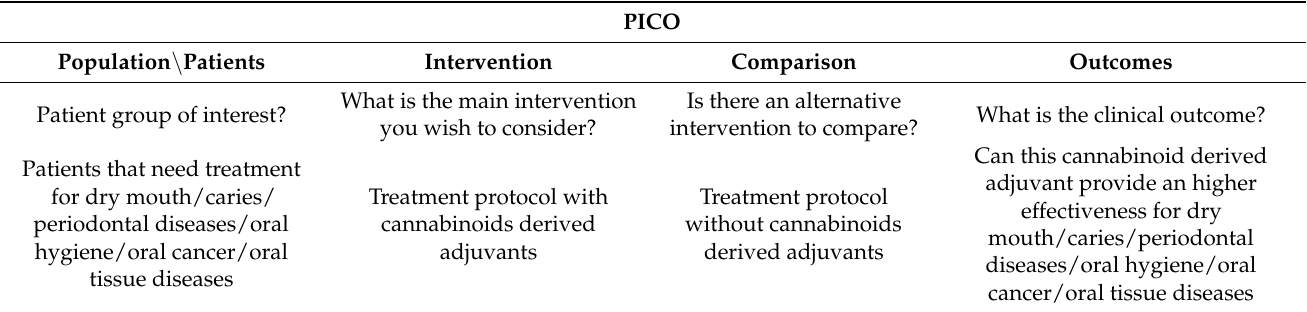
Table 1. PICO questions